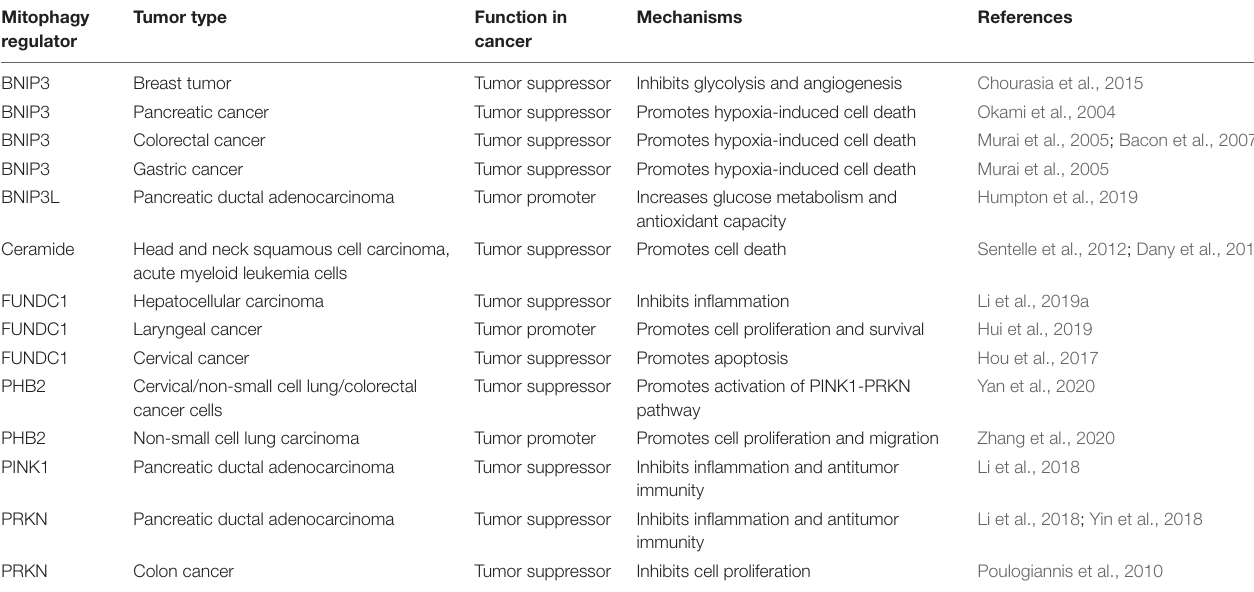
TABLE 1 | Role of mitophagy regulators in